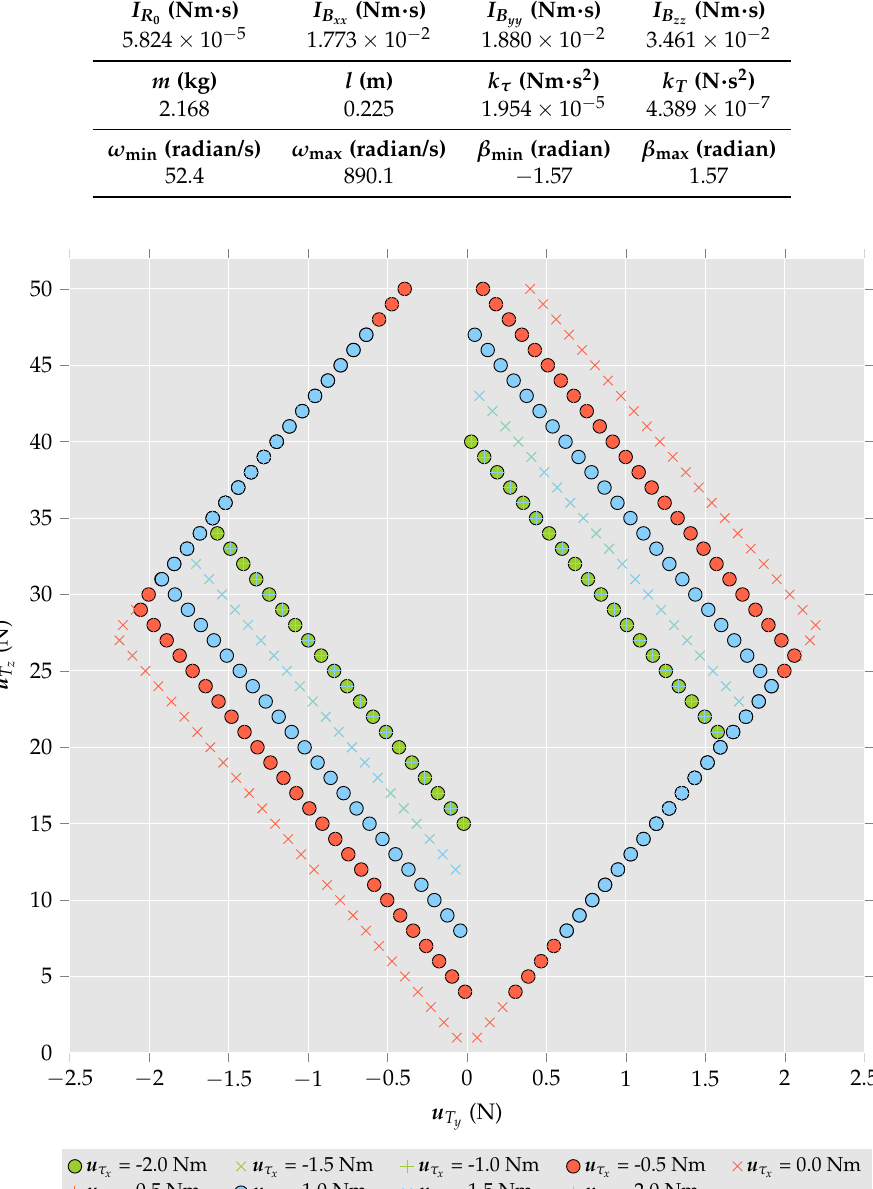
that can be achieved given a set of u T y